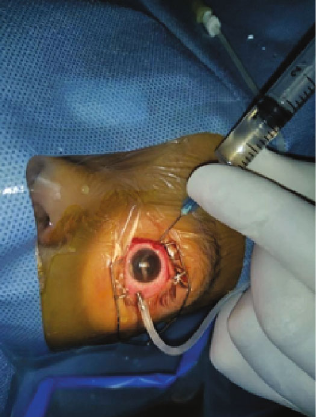
Figure 4: Diagnostic vitreous tap of the left eye showing light yellow aspirate in the syringe.